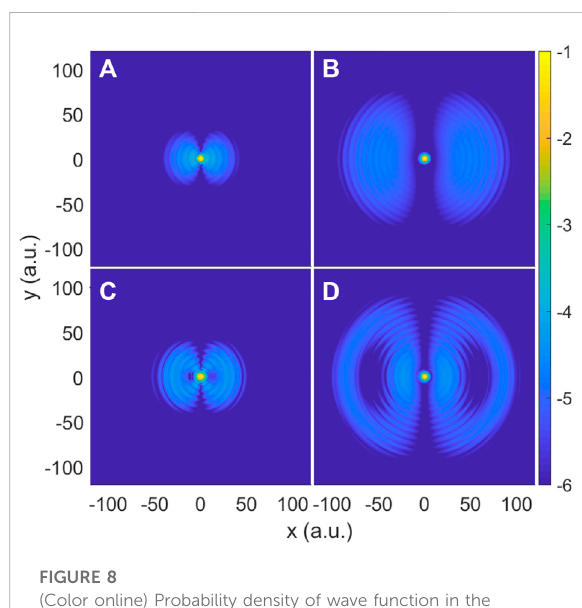
FIGURE 8 (Color online) Probability density of wave function in the middle and at the end of laser pulses. All parameters are the same as those in Figure 3A, except for the peak intensities: (A,B) I 0 = 5